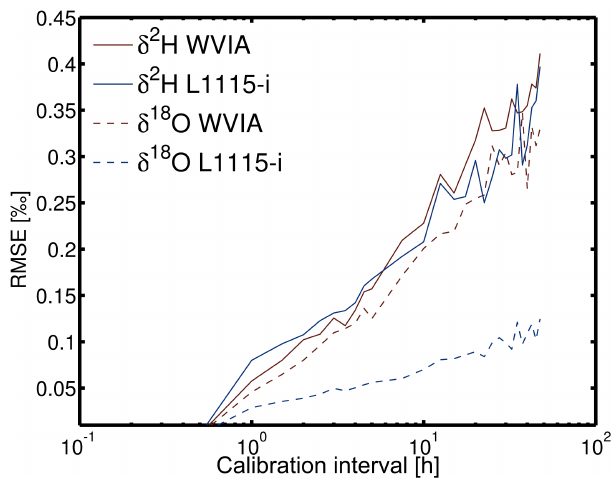
Fig. 10. Root mean square error (RMSE) of laser spectroscopic iso- tope measurements as a function of intercalibration time on a log